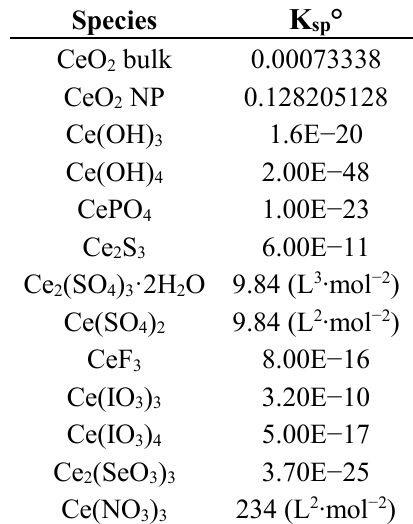
Table 2. Solubility and solubility constants for selected Ce compounds [8–13] Units are in grams per 100 g H O unless otherwise mention in the 2